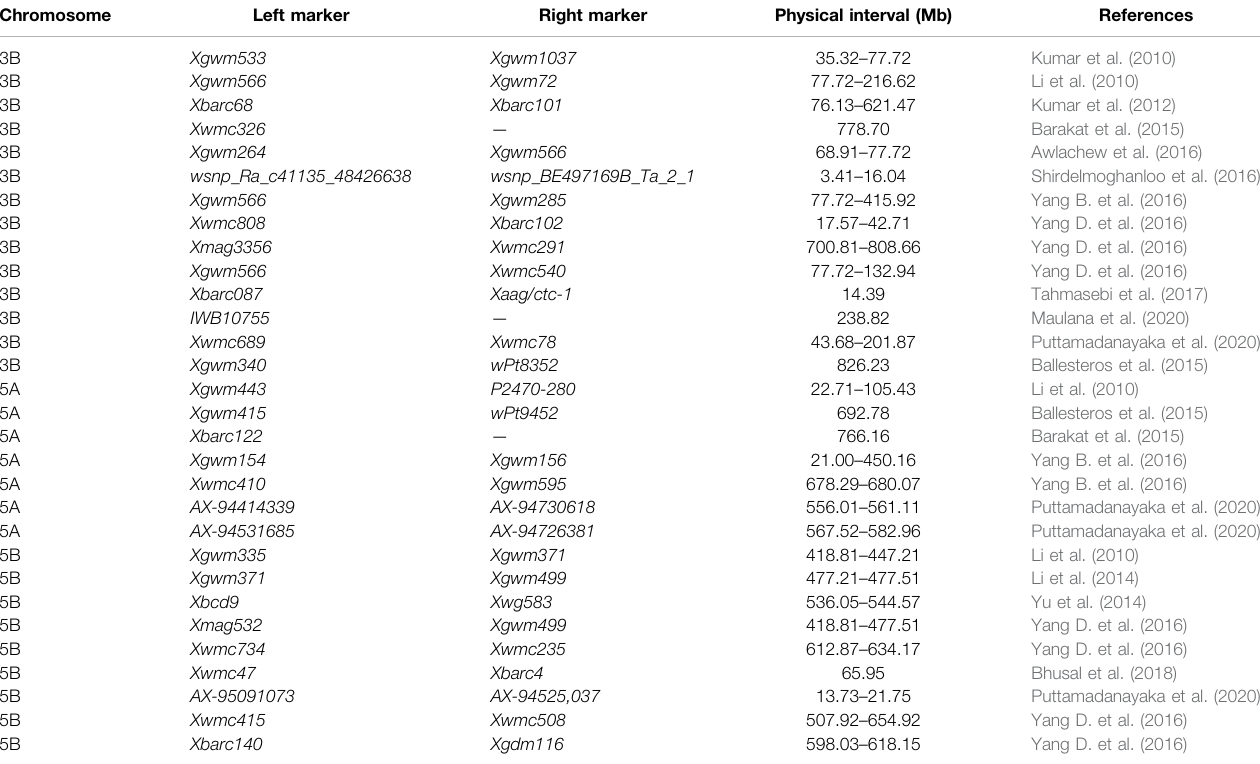
Spanning markers were used to locate positions in the physical map if the certain markers failed to be located on the physical map. The physical locations of some markers were not available leaving the physical location as a single marker.